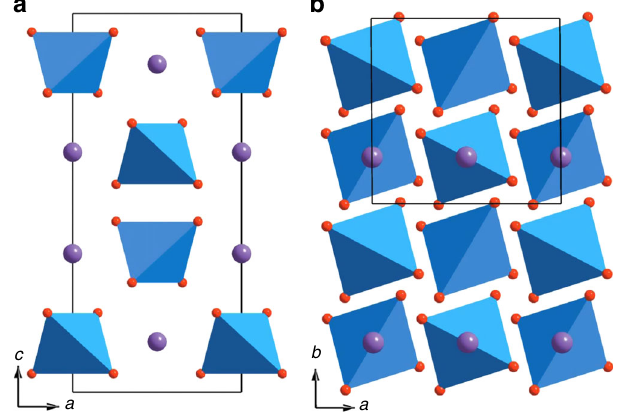
Fig. 1 The BiVO 4 Scheelite structure. a [010] and b [001] projections. The violet and red spheres denote Bi and O atoms, respectively. The V atoms (not shown) are at the center of the